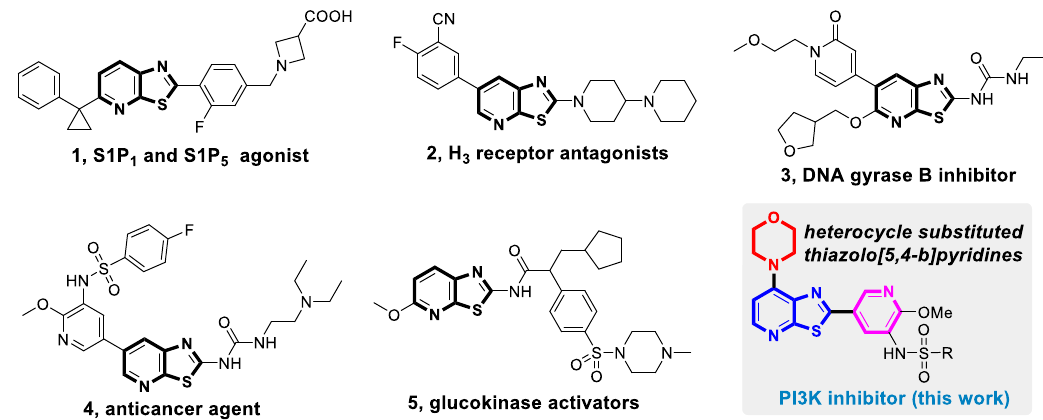
Figure 1. Selected biological compounds with thiazolo[5,4- b ]pyridine skeleton.